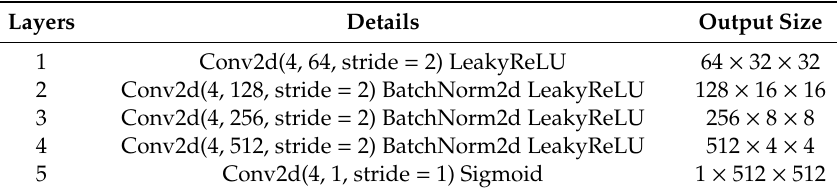
Table 3. Proposed discriminator network’s structure.